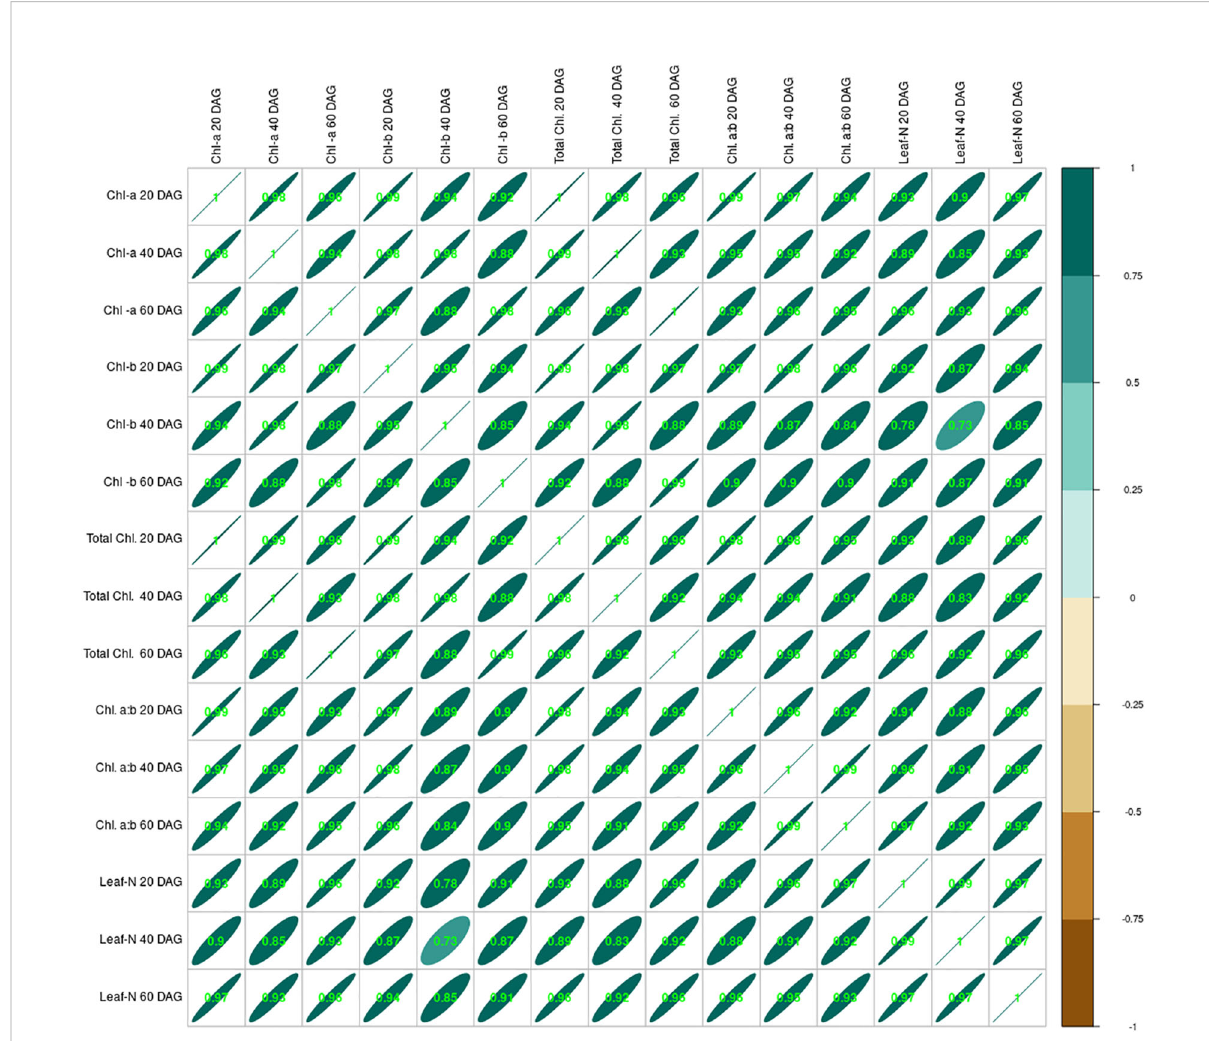
FIGURE 3 Correlation between leaf nitrogen content at 20, 40, and 60 DAG and chlorophyll ( a , b , total and a : b ) of French bean. DAG, days after